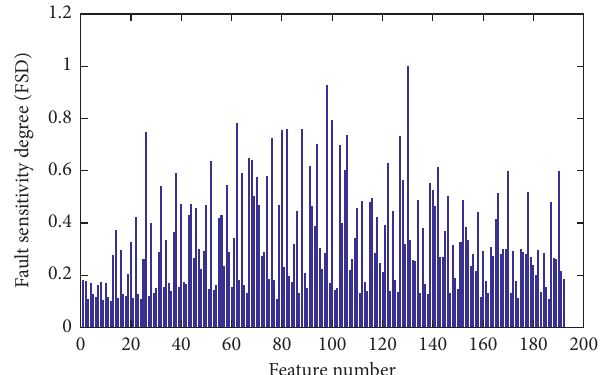
Figure 29: The fault sensitivity degree.